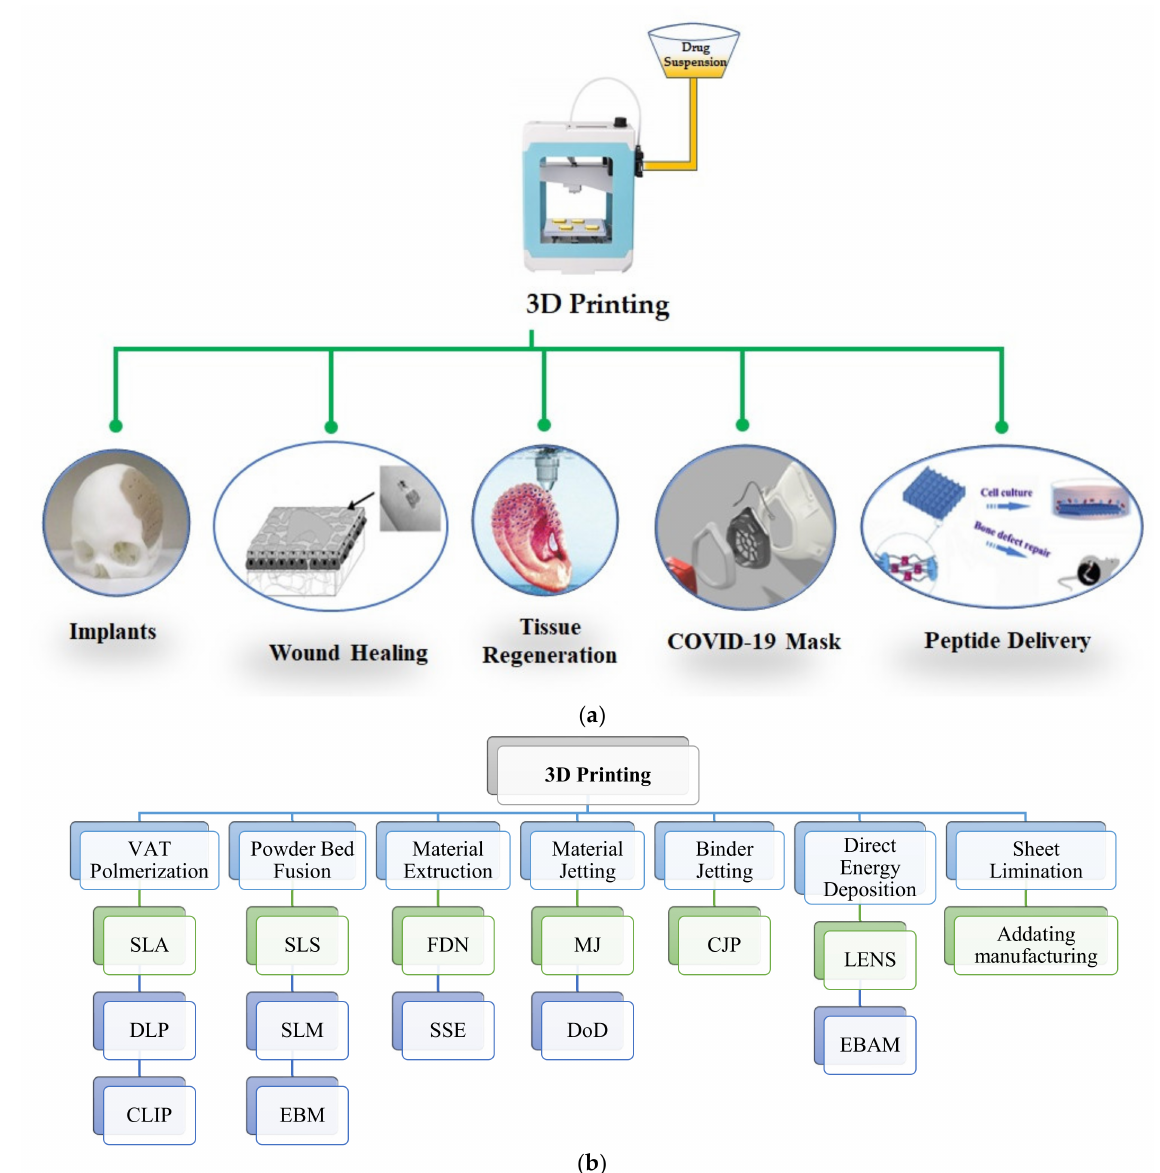
Figure 4. ( a ) Diagrammatic representation of applications of 3D printing in personalized nanomedicines. ( b ) Schematic presentation of different approaches of 3D printing in personalized nanomedicines: CLIP-continuous liquid interface production, CJP—color jet printing, DLP—digital light processing, DoD—drop-on-demand, EBAM—electron beam additive manufacture, EBM—electron beam melting, FDM—fused deposition modeling, LENS—laser engineered net shape, MJ— material jetting, SLA—stereolithography, SLM—selective laser melting, SLS—selective laser sintering, and SSE—semisolid extrusion. Redrawn with permission from